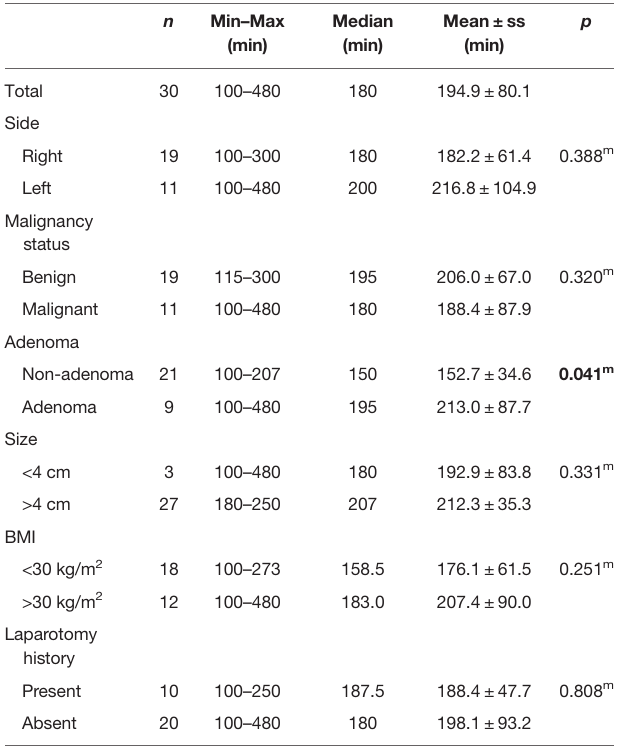
TABLE 2 | Adrenal gland pathologies of 30 evaluated patients. Pathology